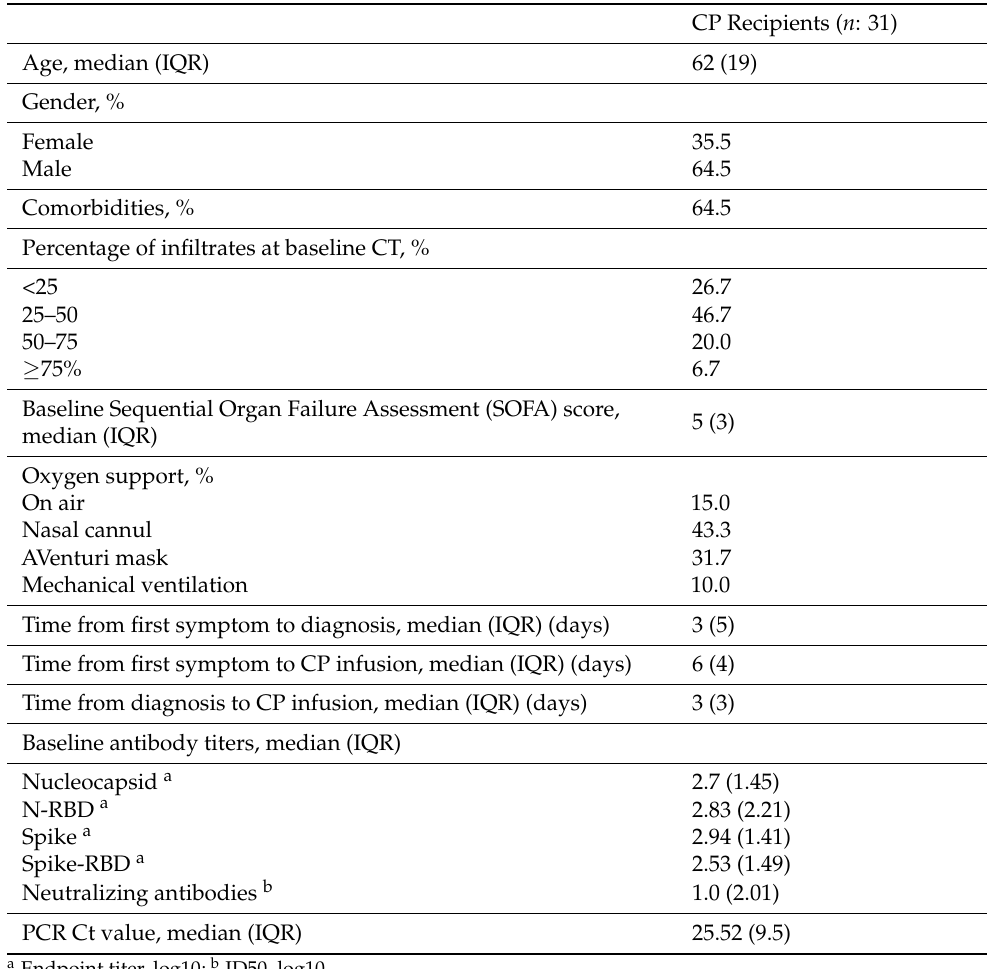
Table 1. Baseline characteristics, antibody titers, and PCR Ct values in 31 recipients CP